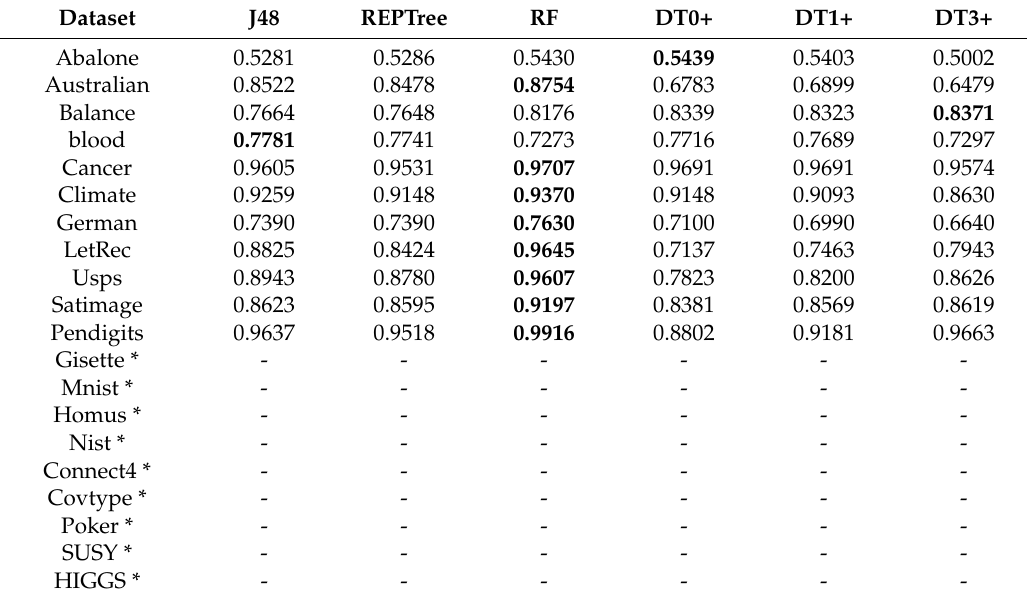
Table 13. Accuracy results of some of the proposed DTs compared to that of some of the well-known decision